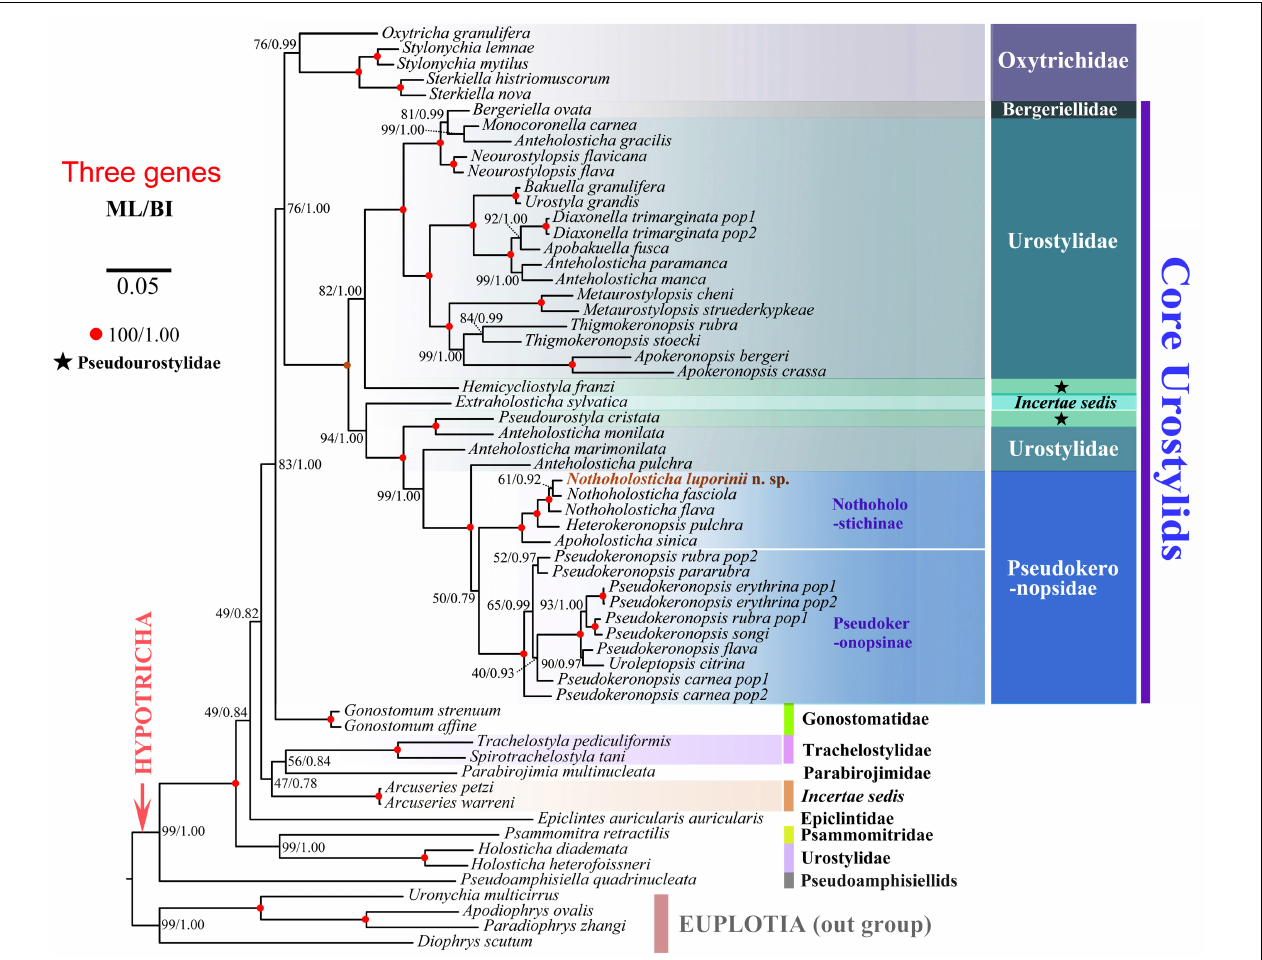
FIGURE 8 | Maximum likelihood tree inferred from SSU rDNA, ITS region and LSU rDNA sequences, showing the systematic position of Nothoholosticha luporinii n. sp. (indicated in red). Numbers near branches denote bootstrap values for maximum likelihood (ML) and posterior probabilities for Bayesian inference (BI). GenBank accession numbers are provided in Supplementary Table S2 . Scale bar corresponds to five substitutions per 100 nucleotide